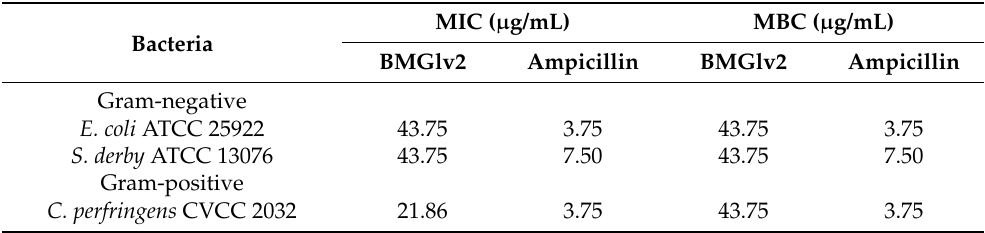
Table 2. MIC values and MBC values of